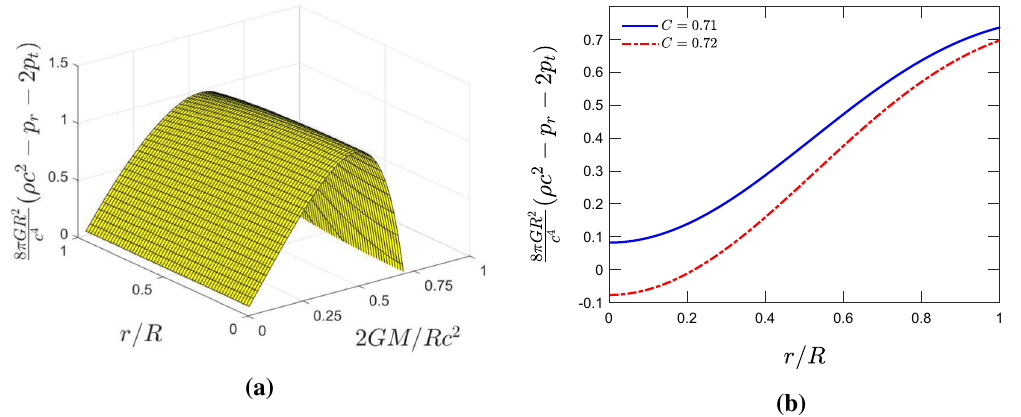
Fig. 5 For sufficiently high compactness, SEC as in condition (41) is violated